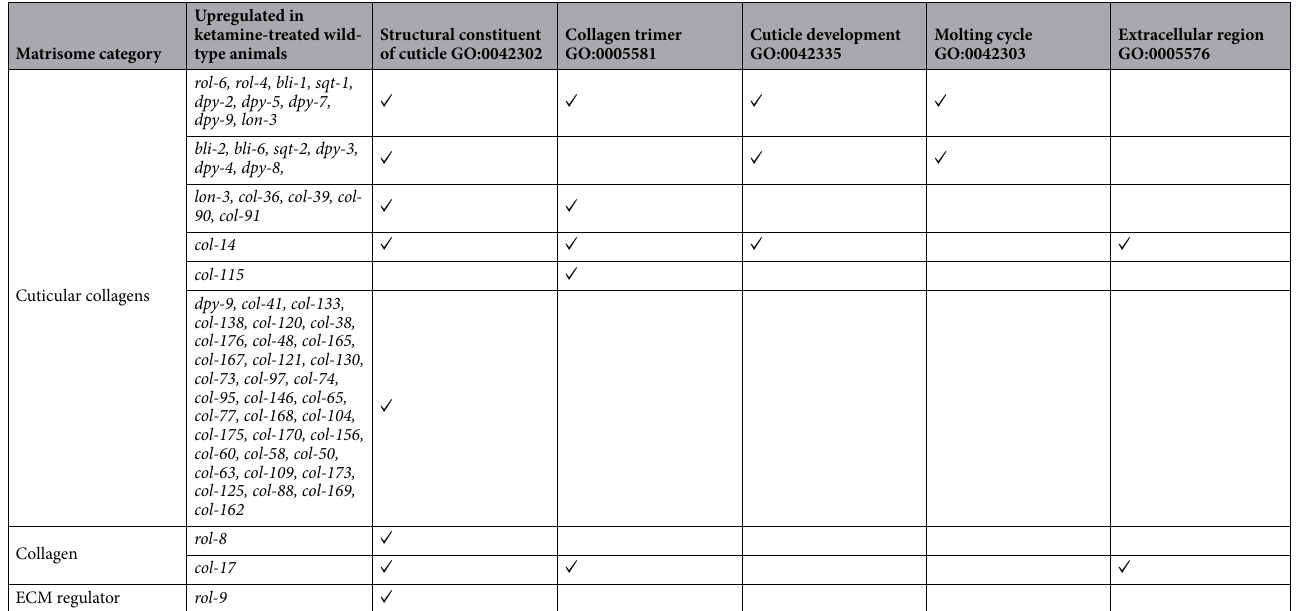
Table 1. RNA-seq identifies ketamine-treatment upregulates 30% of the cuticular